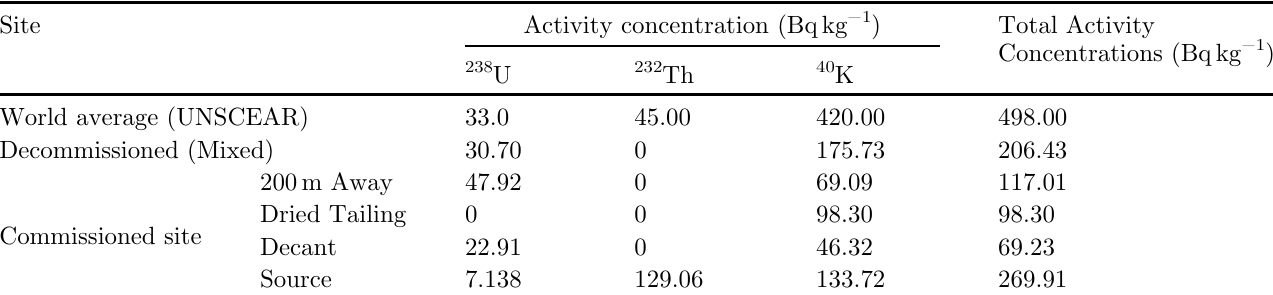
Fig. 1. Regional map showing location of Vatukoula and the sample sites. Table 2. Activity concentrations of 238 U, 232 Th and 40 K in mine tailing samples with the world average values adapted from the (UNSCEAR